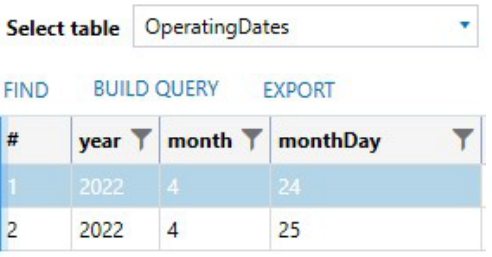
Figure 9. Recovered operating dates of the app within the observations.db